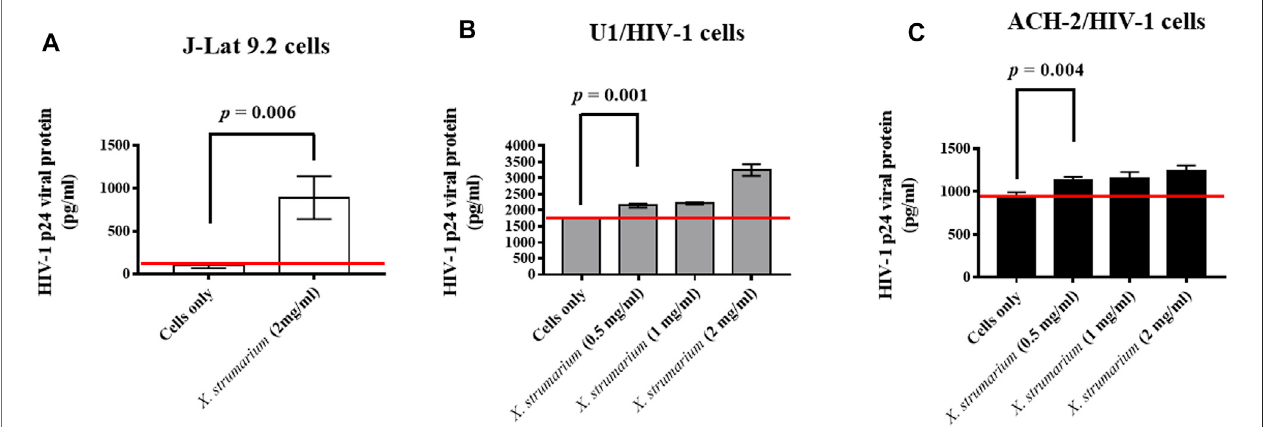
FIGURE3| Effectof X.strumarium onHIV-1p24viralproteinexpressionsunderthecontrolofHIV-15 ′ -LTRinU1andACH-2cells,respectively. (A) J-Lat9.2cells weretreatedwith X.strumarium (2 mg/ml)for48 h. (B) U1cellsweretreatedwith X.strumarium withinvariousconcentrations(0,0.5,1,and2 mg/ml)for48 h. (C) ACH- 2 cells were treated with X. strumarium within various concentrations (0, 0.5, 1, and 2 mg/ml) for 48 h. J-Lat 9.2, U1, or ACH-2 cells only were served as negative controls. The un-treated and treated cell culture supernatants were then detected by a HIV-1 p24 viral protein ELISA kit.